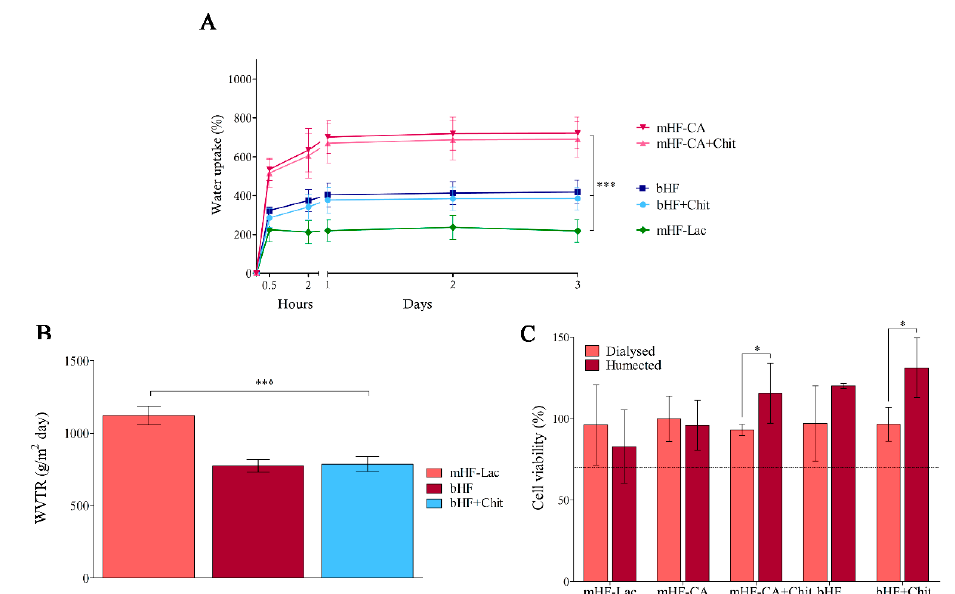
Figure 4. Hydrofilms characterisation. ( A ) Swelling curve. The percentage of water uptake regarding dry weight of the hydrofilms at different time points. *** p < 0.001 among mHF-Lac, bilayer hydrofilms (bHF and